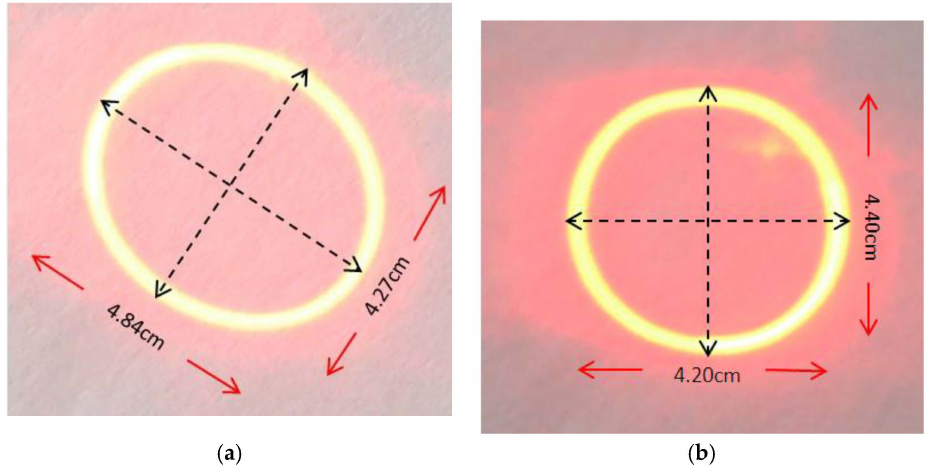
Figure 14. Circular scanning patterns on the screen: ( a ) generated by standard phased-shifted sinusoidal signals; and ( b ) generated by the calculated